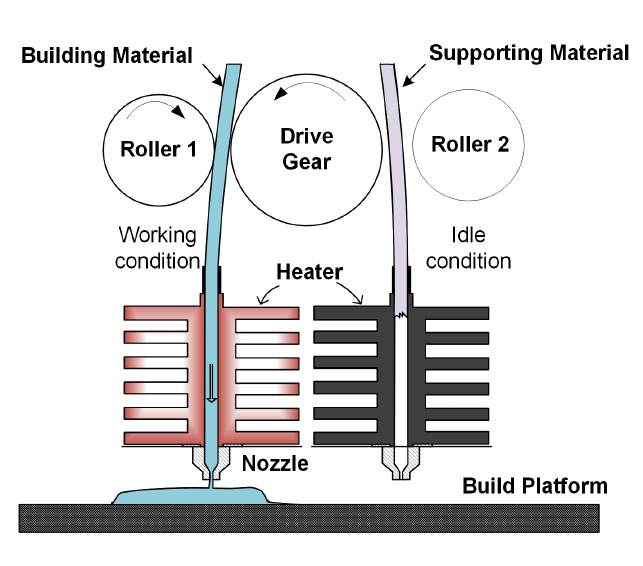
Figure 1. Schematic diagram of extrusion system of